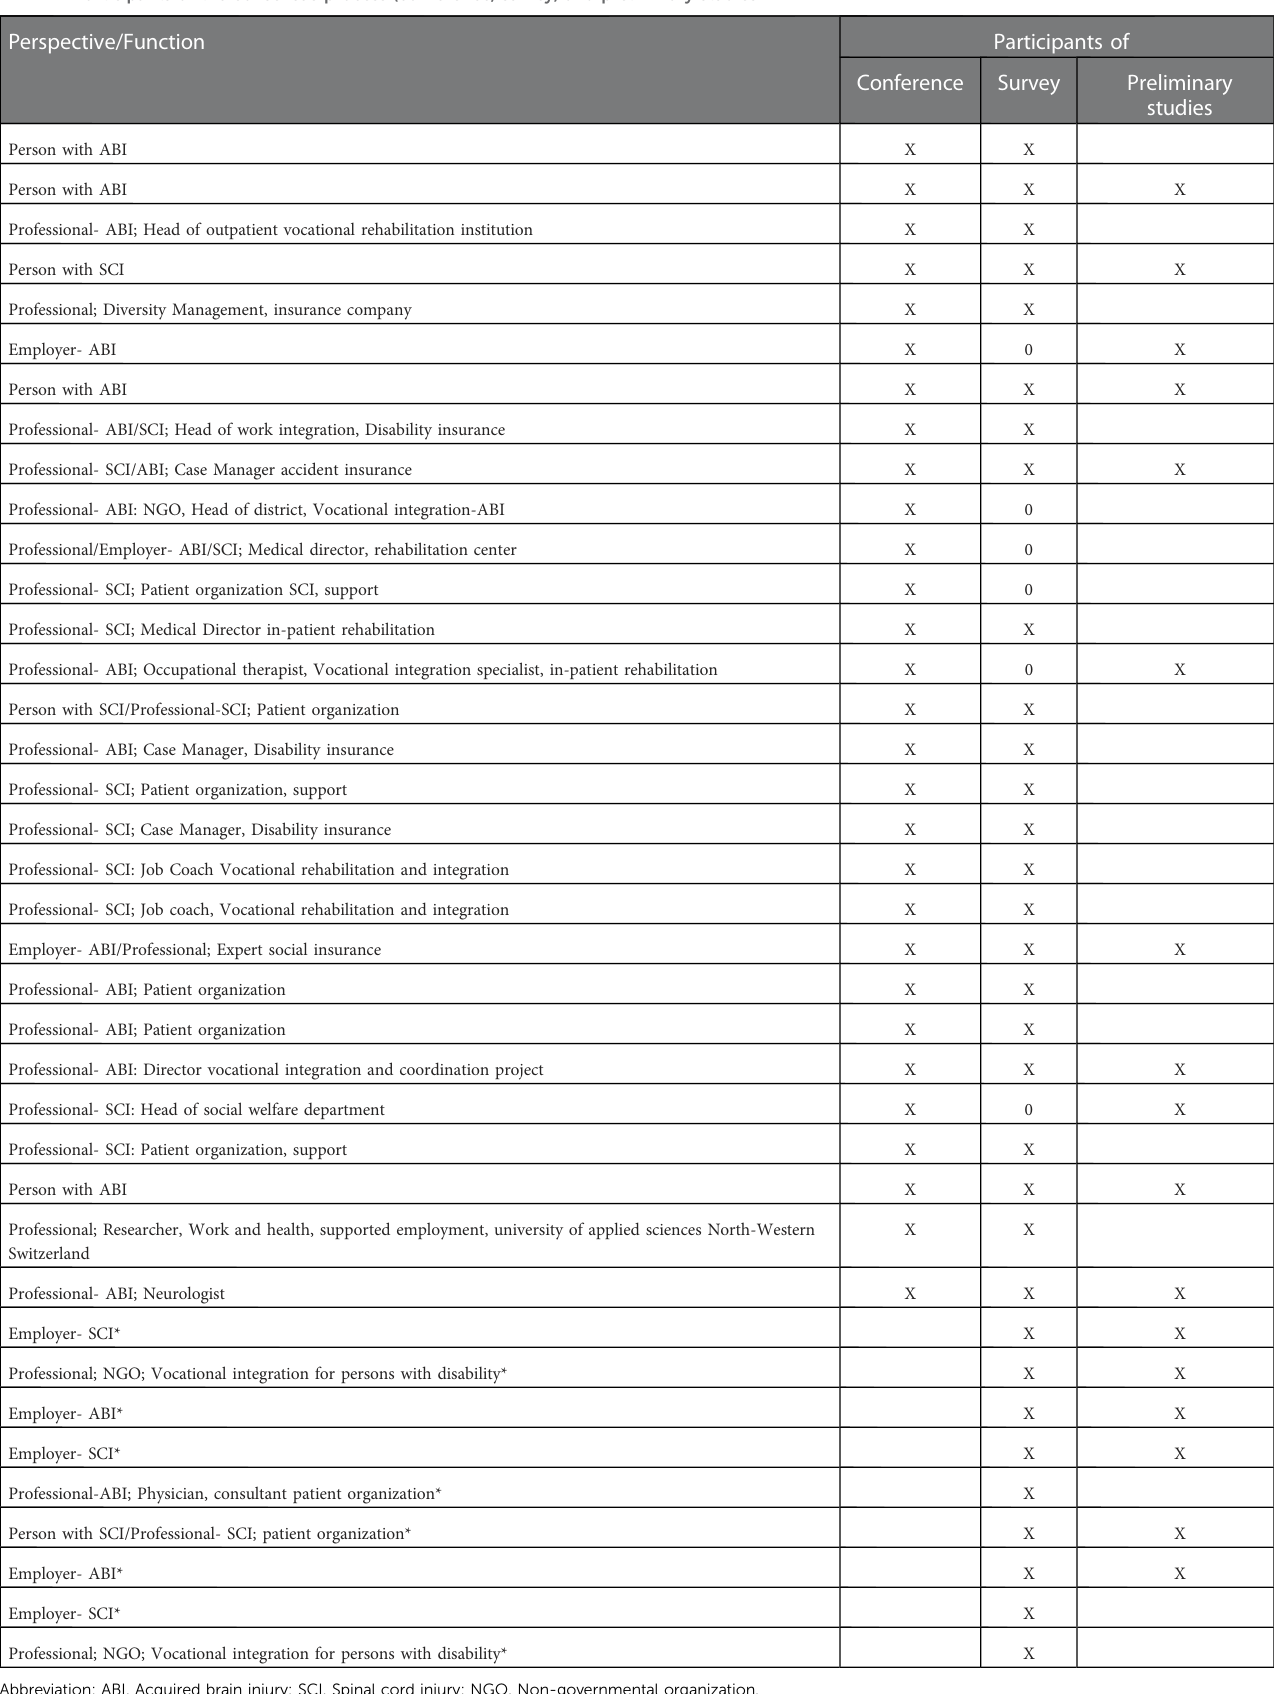
TABLE 1 Participants of the consensus process (conference, survey) and preliminary